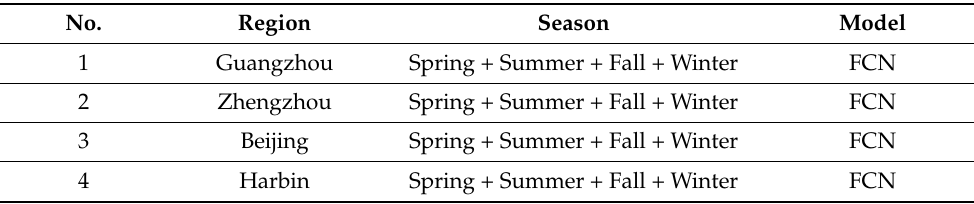
Table 4. Experimental setup for E2.